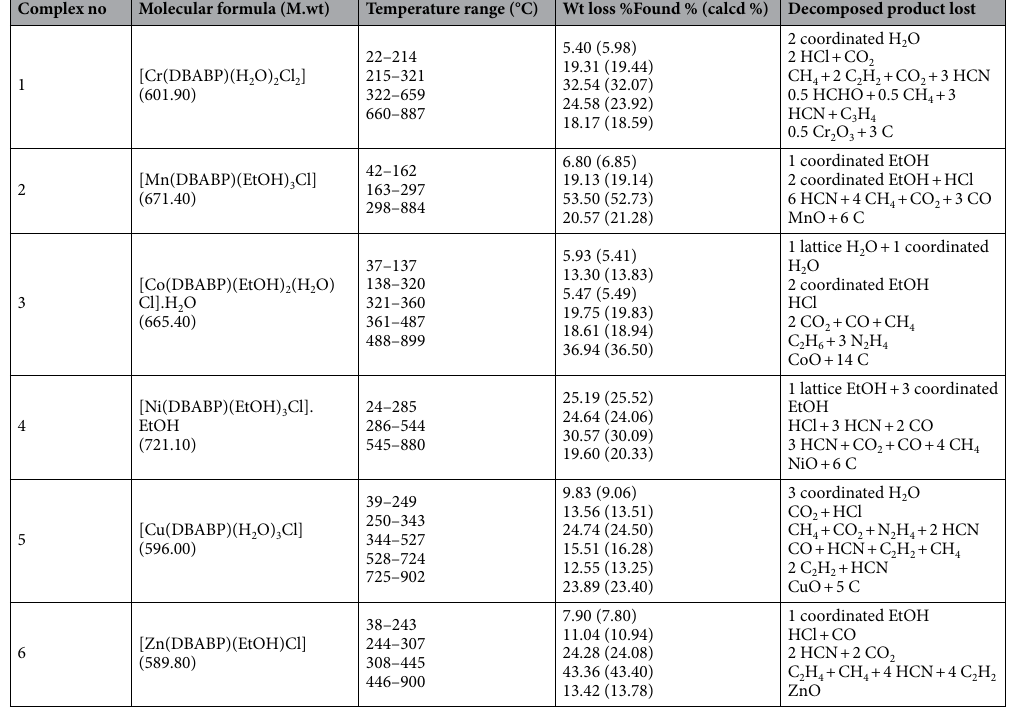
Complex no Molecular formula